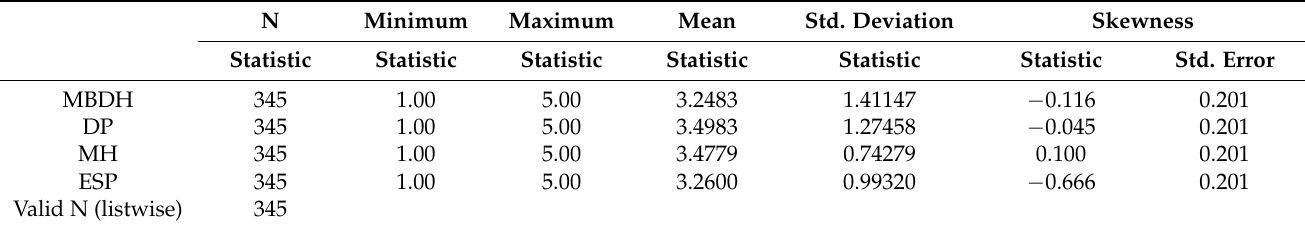
Table 2. Summary of descriptive statistics.